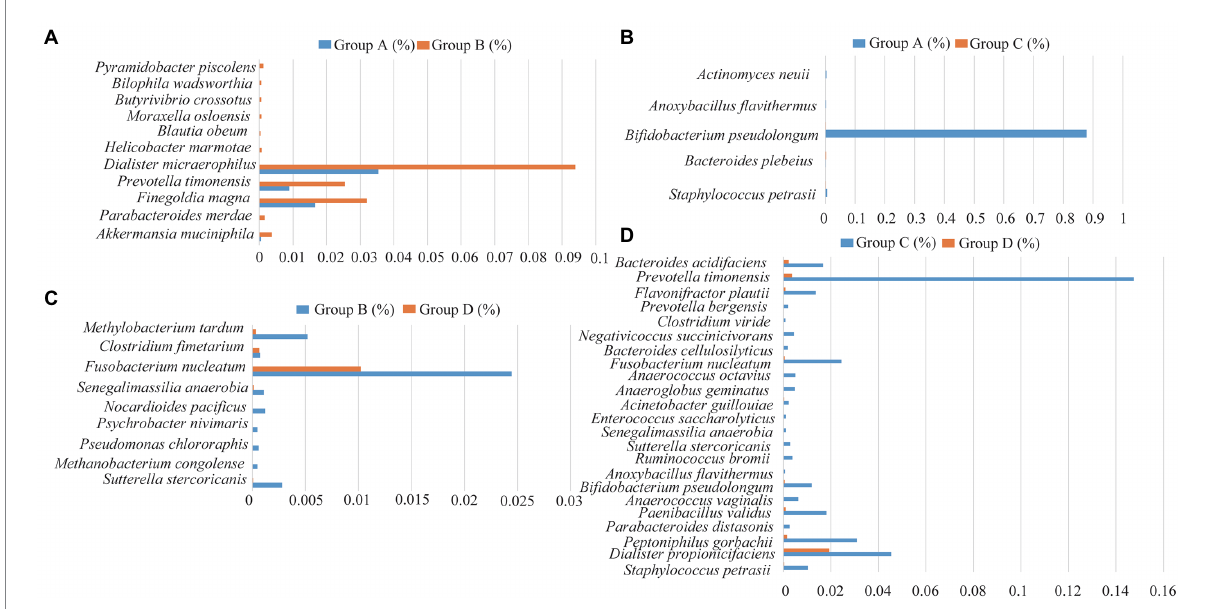
FIGURE 4 Differences in the species of the bacteria between Group A and Group B (A) , Group C and Group D (B) , Group A and Group C (C) , and Group C and Group D (D) , respectively.